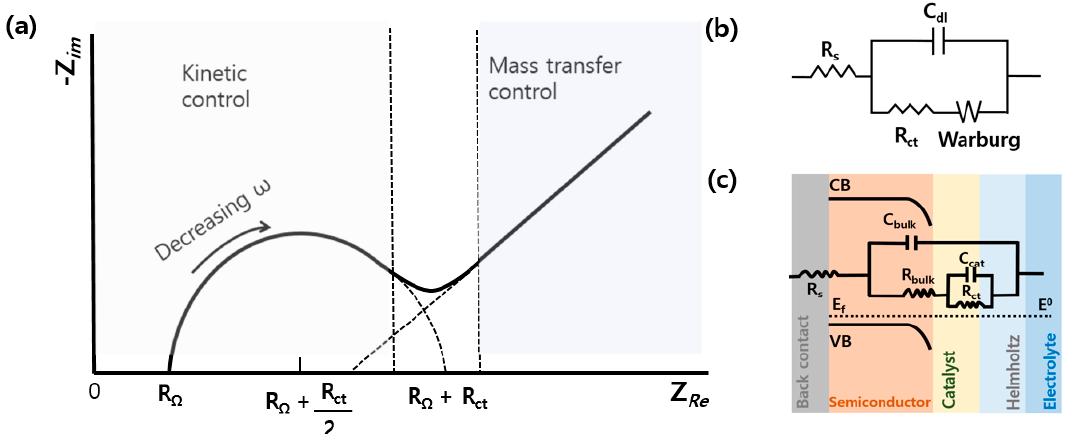
Figure 10. ( a ) A Nyquist plot for electrochemical cell covering regions of mass-transfer limitations (diffusion, Warburg) and kinetic (from kinetics of the electrochemical reaction, charge-transfer resistance). ( b ) The corresponding equivalent circuit representing the plot ( a ). ( c ) An energy diagram of a semiconductor photocathode/electrolyte interface with the corresponding electrical equivalent circuit.